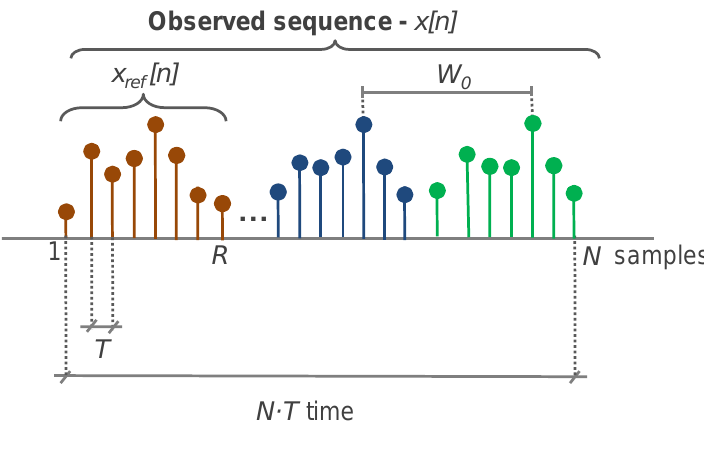
Figure 7. Metric